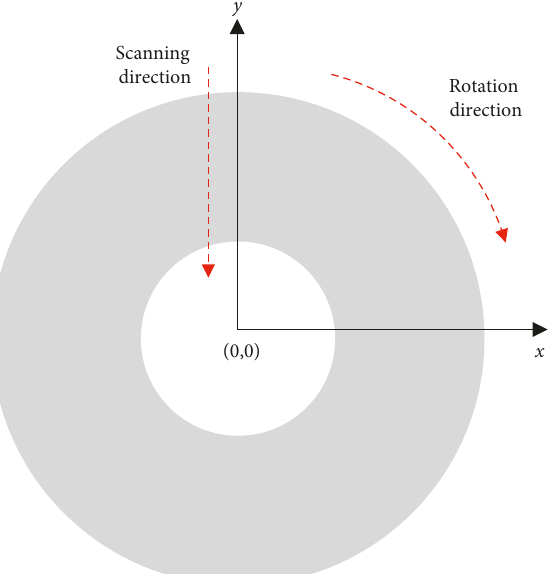
Figure 9: Conceptual diagram of disc position calculation.